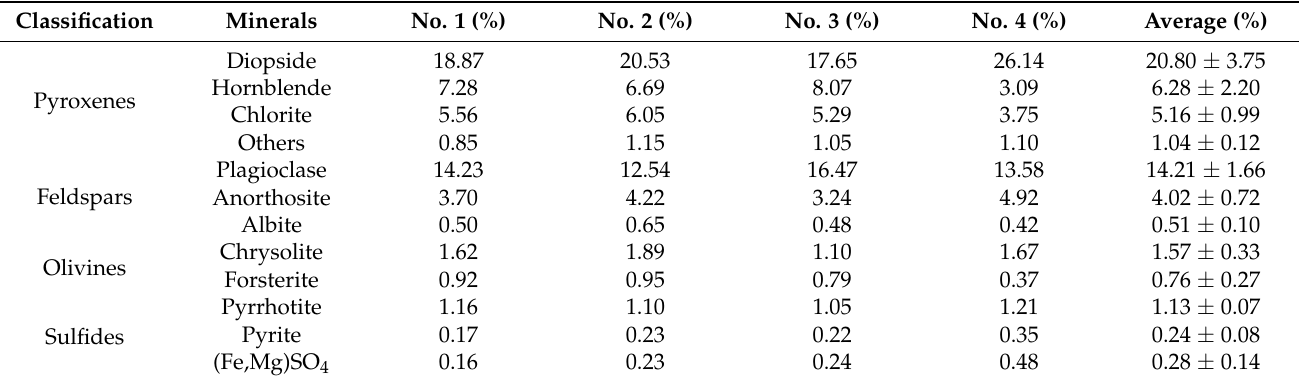
Table 7. Mineral contents of the gangue and sulfide minerals in the different ore